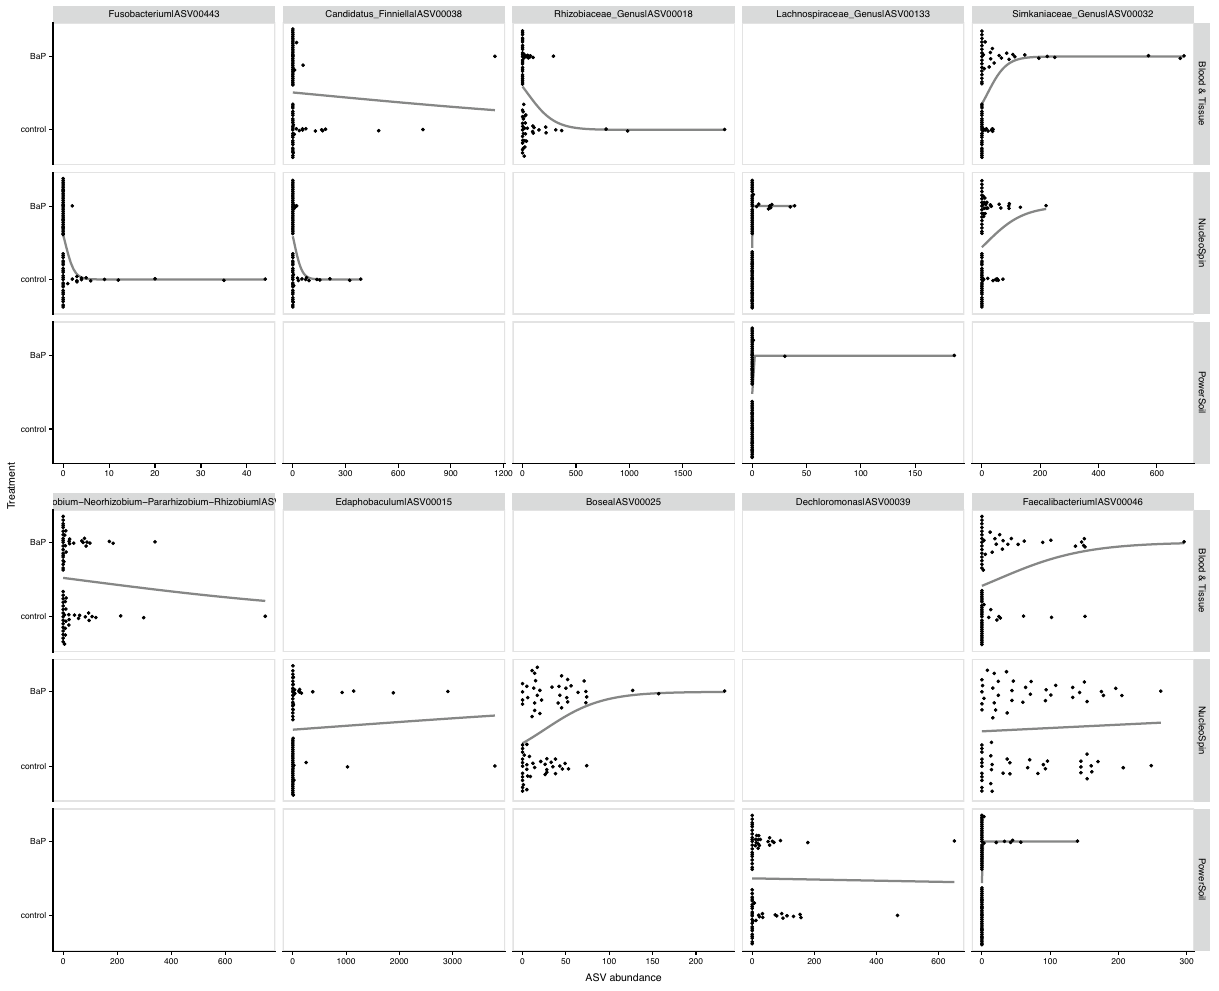
Figure 7. Swarm plots of logistic regressions predicting BaP exposure from individual ASV abundance (centered log-ratio transformed) using data subsets partitioned by dissection method. The top 10 taxa, ordered by importance from the preceding random forest analysis are presented in this figure. Points indicate an ASV’s abundance per each dissection method. Black lines indicate the predicted relationship taken directly from the logistic regression